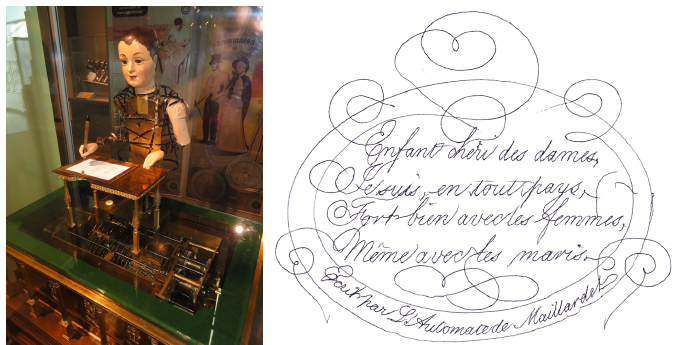
Figure 2. Henri Maillardet’s reconstructed automaton shown here without the original shell (Left, Maillardet (2011)) and the poem that identified the original builder of the machine Maillardet (ca.